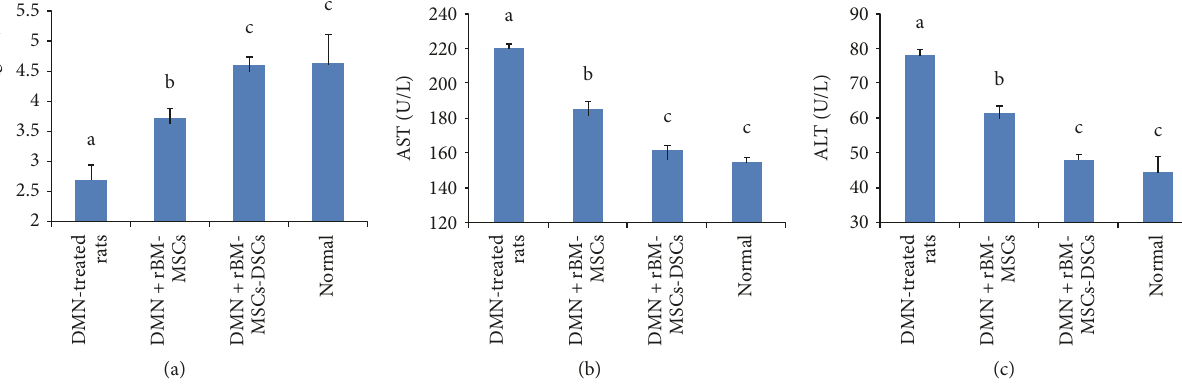
Figure 3: Biochemical analysis of blood sera. (a) Concentration of albumin in blood serum of rats. (b) Concentration of aspartate aminotransferase (AST) in blood serum of rats. (c) Concentration of alanine transaminase (ALT) in blood serum of rats. Bars with di ff erent letter superscripts are di ff erent statistically ( P < 0 05